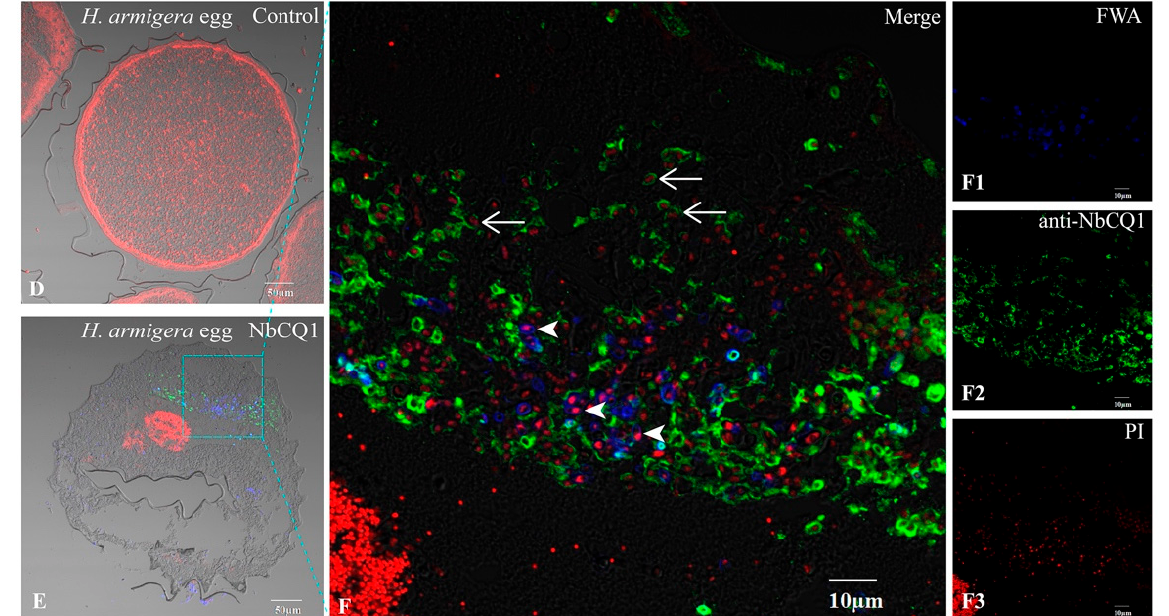
Figure 6. Paraffin sections of S. litura and H. armigera eggs infected by NbCQ1. ( A ) Uninfected S. litura egg; ( B ) NbCQ1-infected S. litura egg; ( C ) An enlarged view of NbCQ1 infections in the oocytes of S. litura egg; ( C1 ) NbCQ1 spores stained with FWA; ( C2 ) Proliferative NbCQ1 labelled with antibody; ( C3 ) Nucleus stained with PI. The arrowhead shows NbCQ1 spores; the arrow shows proliferative pathogens. ( D ) Uninfected H. armigera egg; ( E ) NbCQ1-infected S. litura egg; ( F ) An enlarged view of NbCQ1 infections in the oocytes of S. litura egg; ( F1 ) NbCQ1 spores stained with FWA; ( F2 ) Proliferative NbCQ1 labelled with antibody; ( F3 ) Nucleus stained with PI. The arrowhead shows NbCQ1 spores; the arrow shows proliferative pathogens.